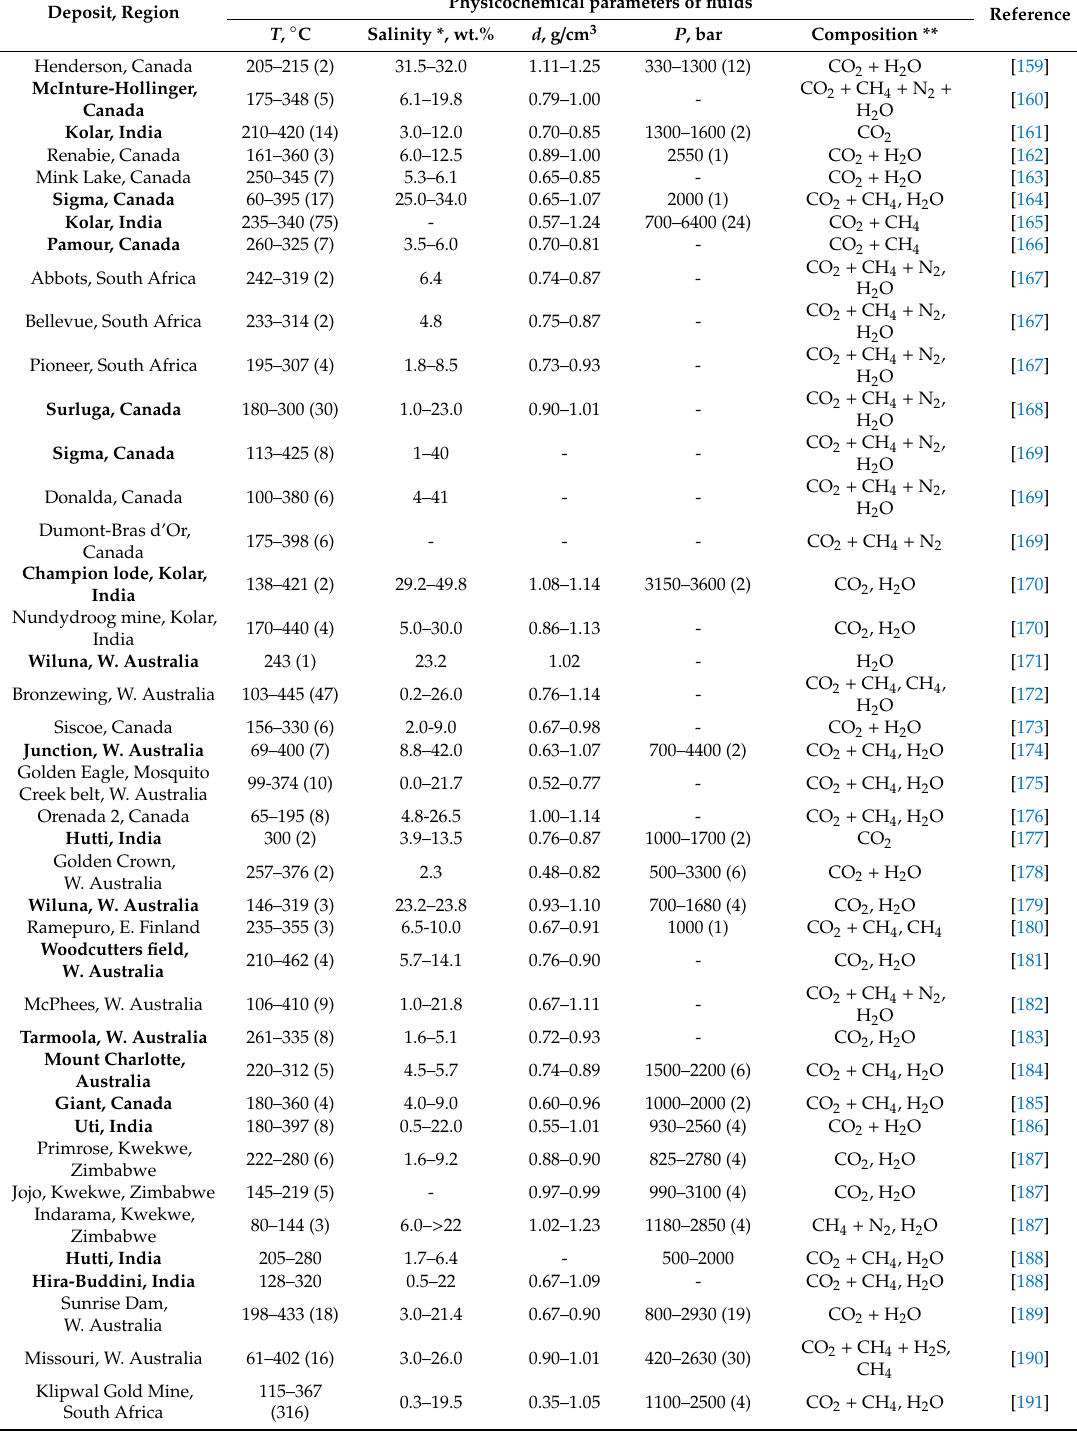
Table 7. Parameters of mineralizing fluids of Meso-Neoarchean gold